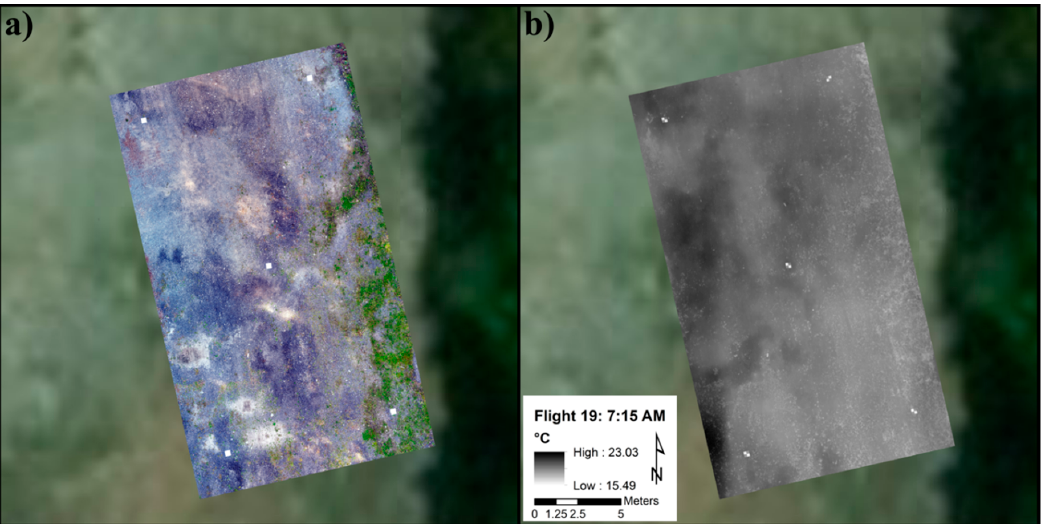
Figure 4. ( a ) Aerial photogrammetry from DJI Phantom 4 Professional 20-megapixel camera. ( b ) apparent temperature orthomosaic from 7:15 A.M. flight. Checkerboard aluminum-paint low-high emissivity ground control points (GCP) can be seen in the corners of the survey area (appearing as white dots). Tree line can be seen to the east (right).